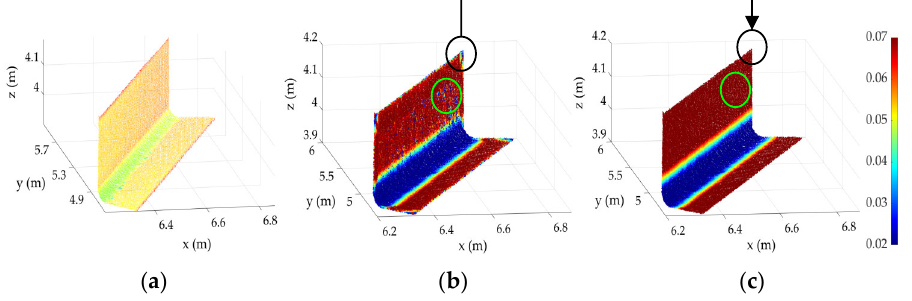
Figure 11. Results of the neighborhood definition: ( a ) sample point cloud, ( b ) Weinmann’s [26] method, and ( c ) using Algorithm 3.